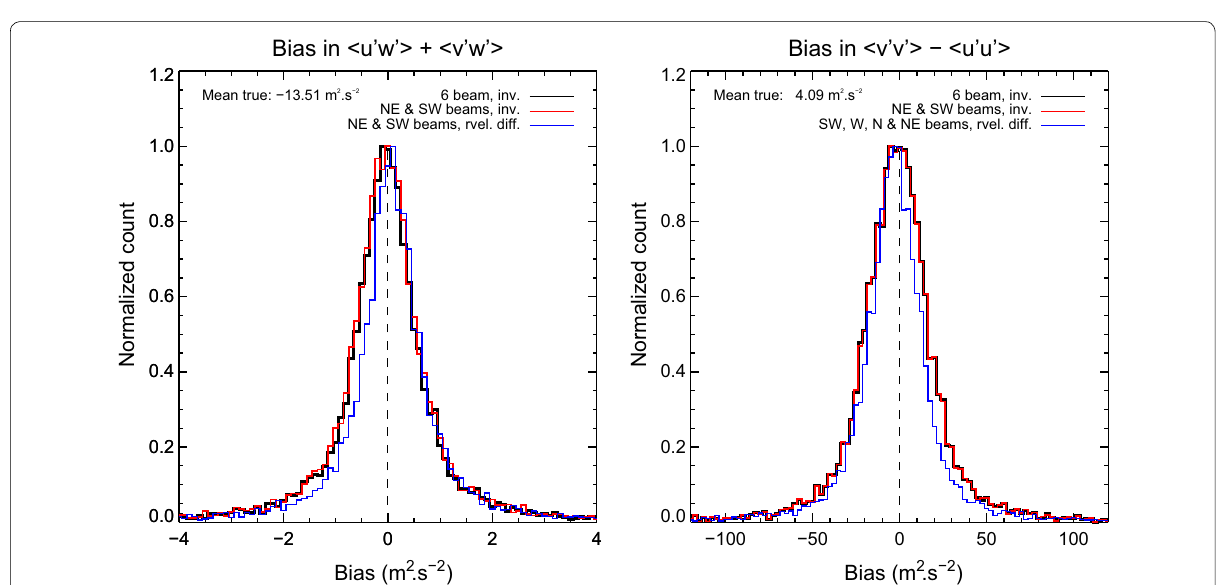
Fig. 11 Bias in measurements of the arithmetic sum of the density-normalized momentum flux and isotropy using the VR83 technique (blue), and a two (red) and six (black) beam least-squares inversion calculated using a simulated gravity wave field. The left-hand panel shows the values of u ′ w ′ + v ′ w ′ for both the inversion-estimated case and that from the covariance calculated from the model’s Cartesian winds at a fixed point (i.e. an estimate of the “true” wind covariance in the